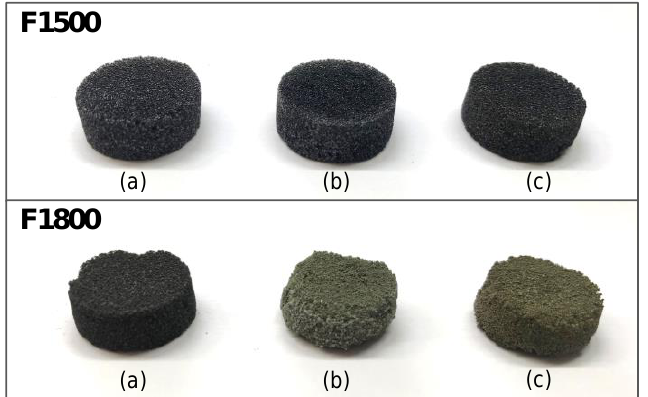
Figure 2. Images of F1500 (above) and F1800 (below) foam samples: (a) as pyrolyzed, (b) after the deposition of the Al 2 O 3 layer (by dip-coating), and (c) after the dispersion of Ru.